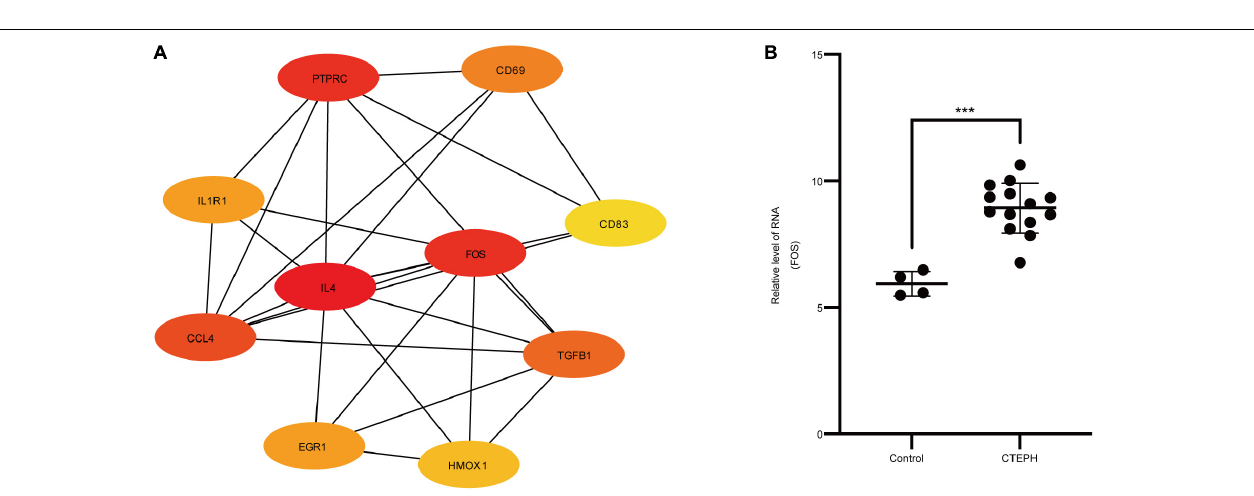
FIGURE 3 | Enrichment analysis of DEGs via GO and KEGG analysis. GO analysis results: (A) BP, (B) CC, and (C) MF. (D) KEGG pathways analysis results. BP, biological process; MF, molecular function; CC, cellular component.